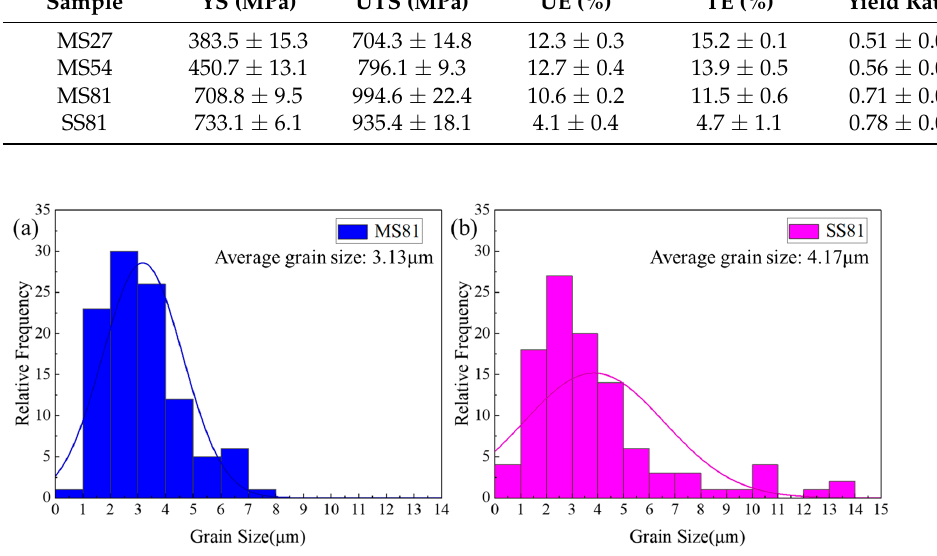
Figure 5. Ferrite grain distribution in ( a ) MS81 and ( b )